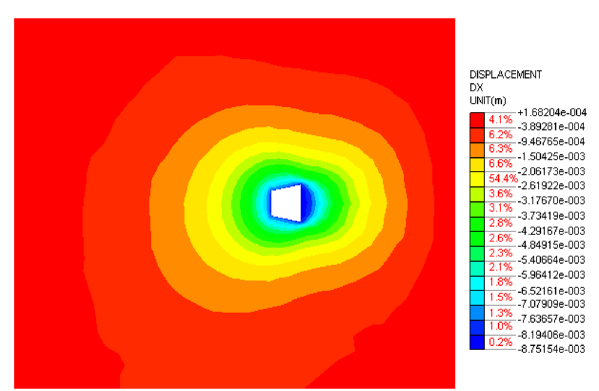
Figure 24. Displacement fringe of soil around the anchor piers for 400 kN.